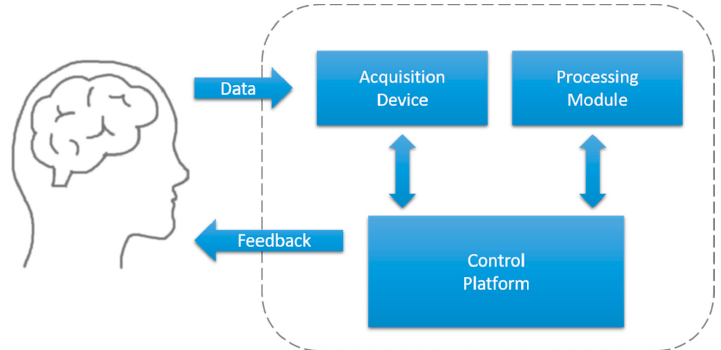
Figure 3. Diagram of a closed-loop feedback system.